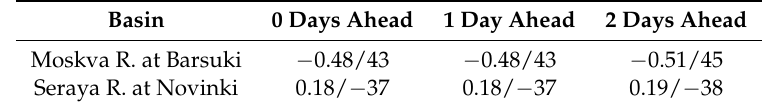
Table 4. OpenForecast performance summary for the period of its operational evaluation. The numerator and denominator values stand for NSE and Bias,